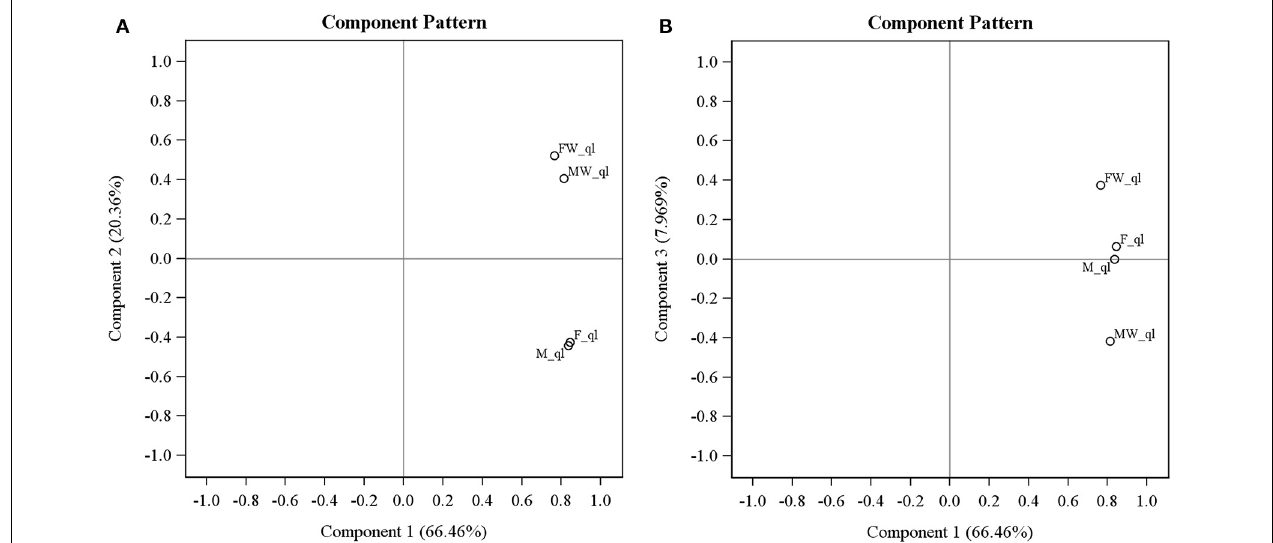
FIGURE 2 | Principal component analysis of gene expression levels in four Zyginidia samples: infected females (FW), infected males or intersex females (MW), uninfected females (F) and uninfected males (M). The first three PCs are depicted here. PC1 is correlated with all sample labels